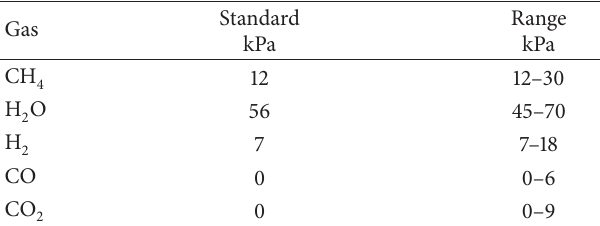
Table 1: Overview of the gas composition at standard conditions and the range each gas is varied